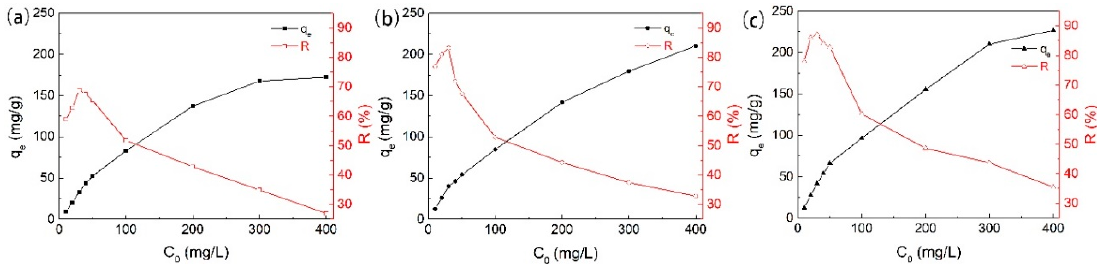
Figure 6. Effects of the initial phenol concentrations on the adsorption on (a) GAC 950 , (b) PAC 800 , and (c) PAC 1000.